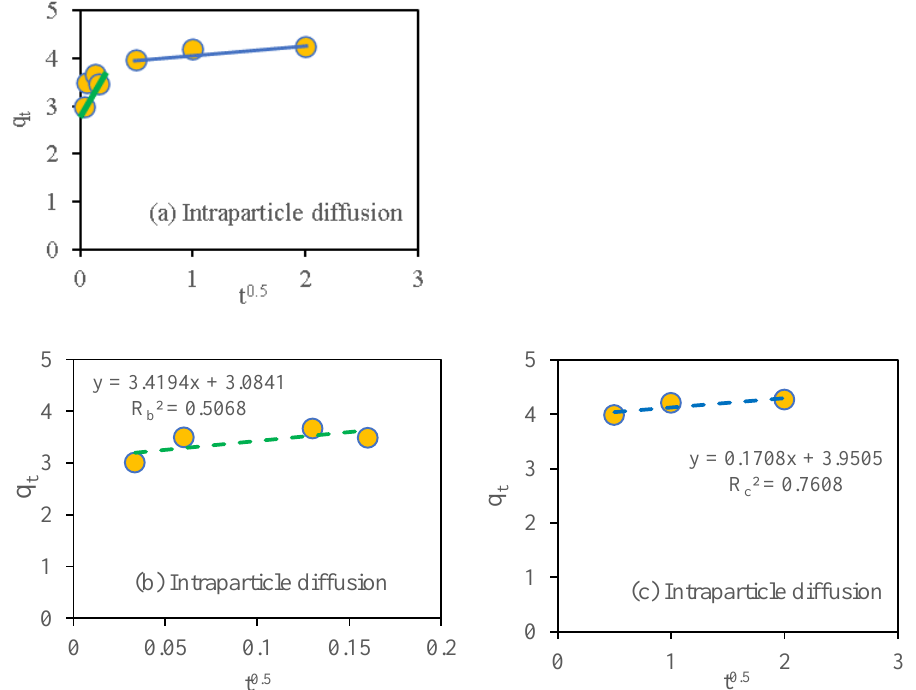
Figure 8. Adsorption kinetics (intraparticle diffusion) of nitrate (initial concentration of nitrate was 60 mg L − 1 ). ( a ) Intraparticle diffusion; ( b ) Intraparticle diffusion slope 1; ( c ) Intraparticle diffusion slope